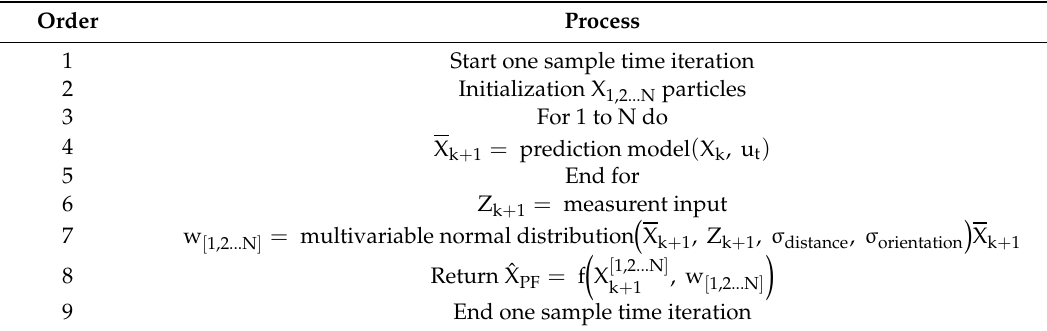
Table 1. Pseudo code of the particle filter.